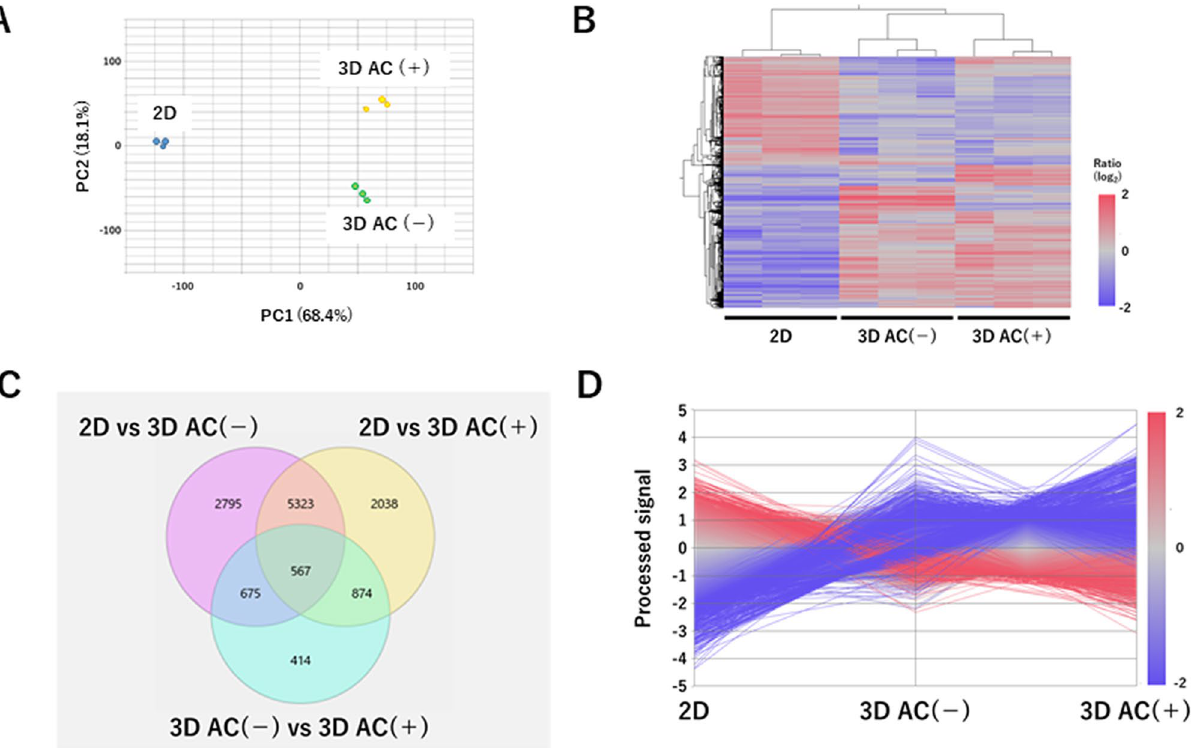
Figure 3. Gene expression in human articular cartilage-derived chondrocytes using a culture method. ( A ) Principal component analysis (PCA) of regularized-logarithm transformed read counts, in which three culture method groups were separated along the axis of major variation (PC1, 68% of variance). 2D: 2-dimensional culture, 3D: 3-dimensional culture. ( B ) Hierarchical clustering of 16,586 genes whose transcript levels